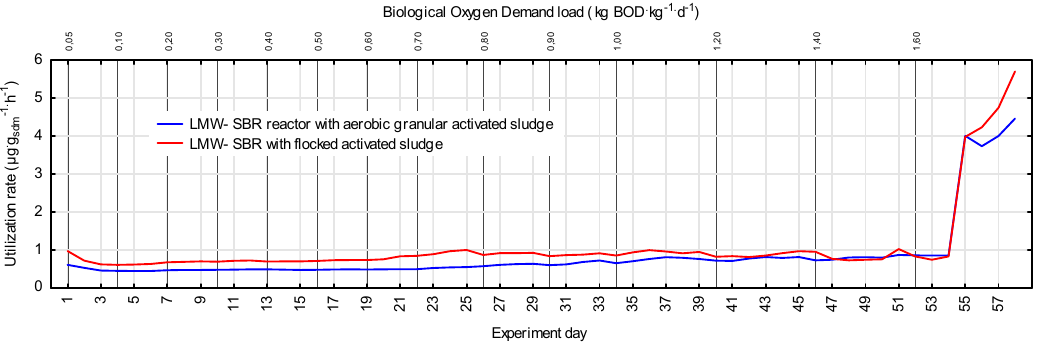
Figure 4. Sum of low molecular weight polycyclic aromatic hydrocarbons ( Σ LMW) utilization rate in aerobic